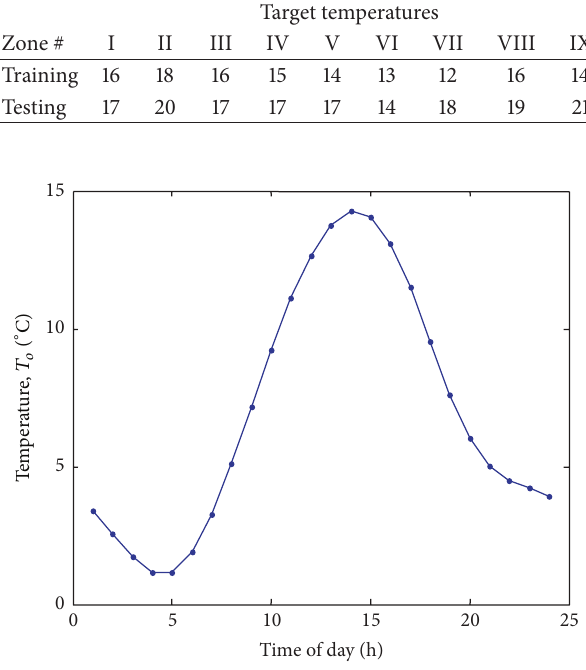
Figure 5: Empirical estimation of 𝑇 𝑜